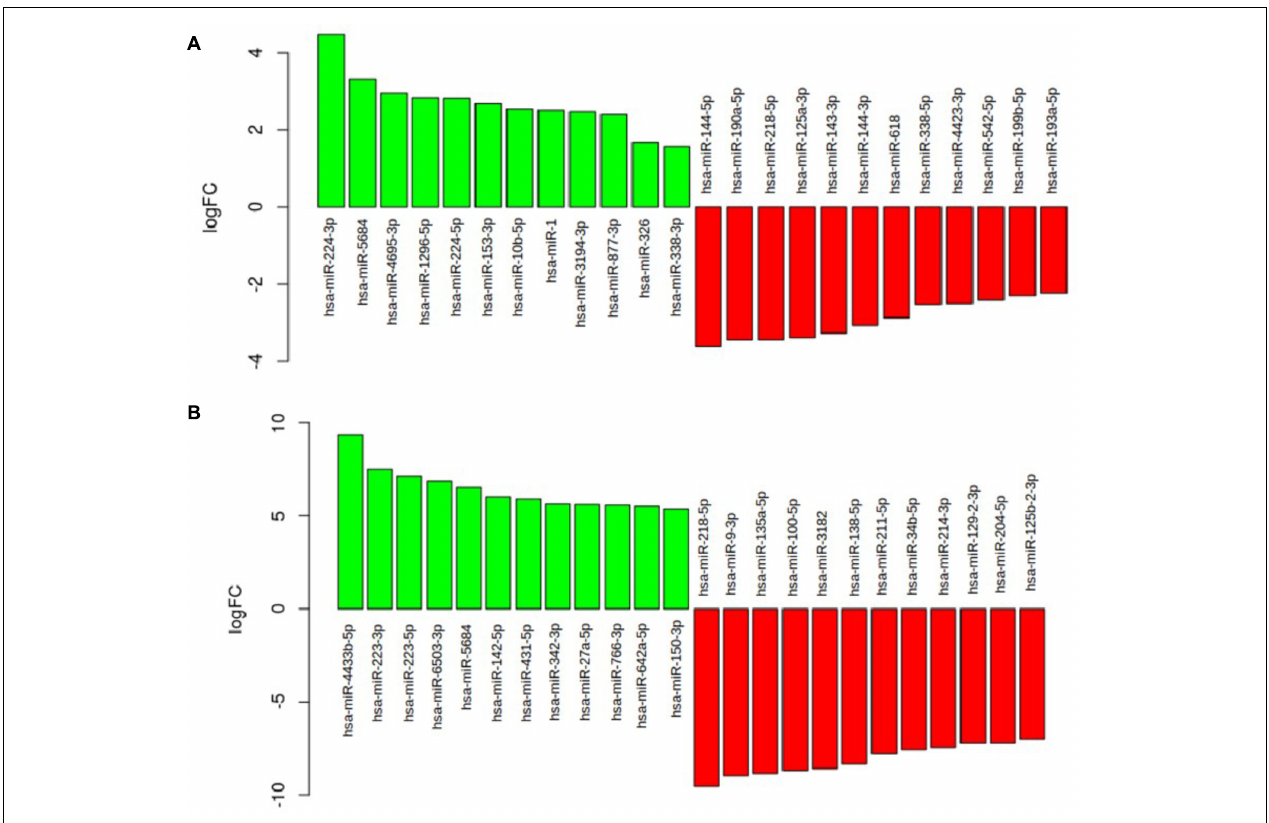
FIGURE 4 | (A) The barplot show the most deregulated miRNAs in the comparison between the ALS blood and the control blood. (B) The barplot show the most deregulated miRNAs in the comparison between ALS neuromuscular junction and the control blood.